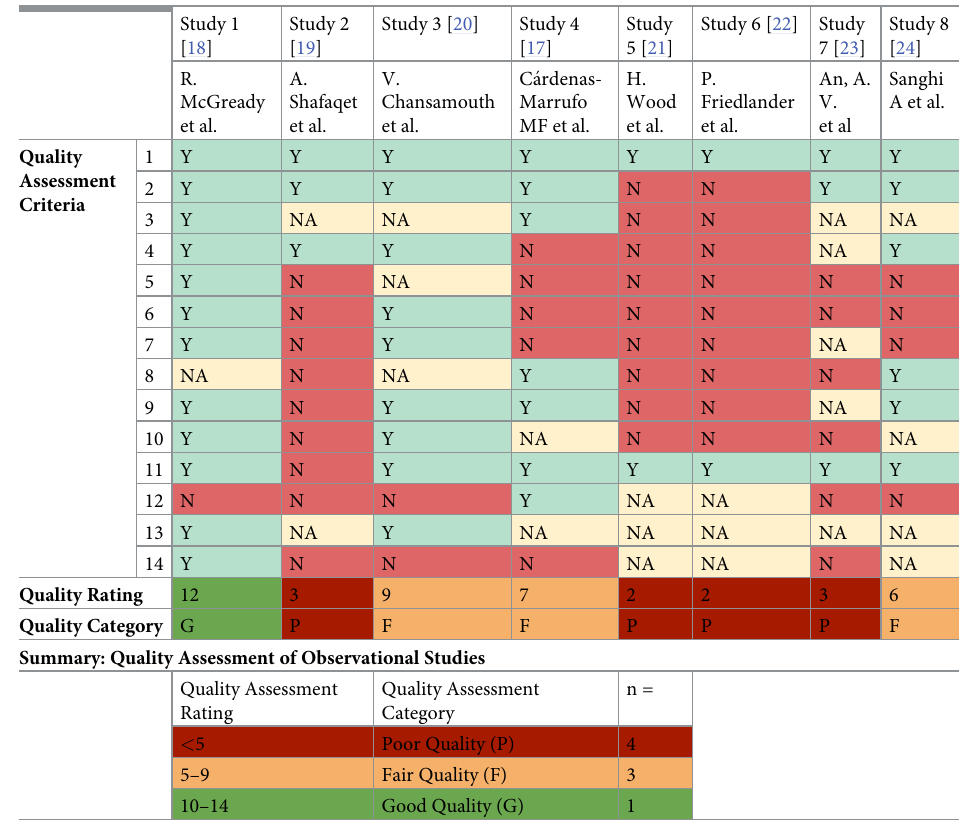
Table 2. Quality Assessment of Observational Studies.